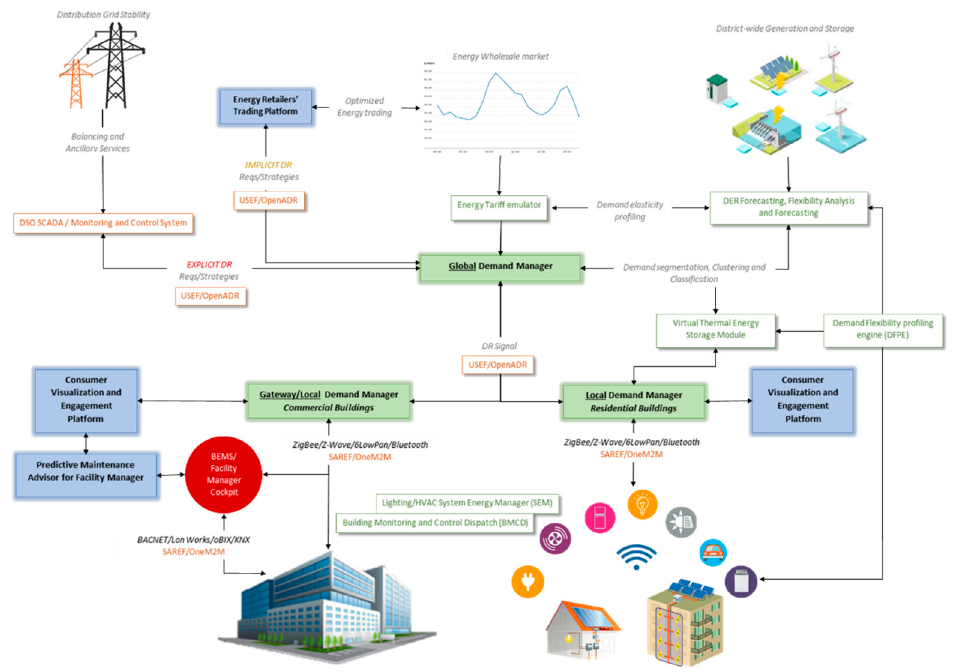
Figure 1. Detailed representation of the architecture of the